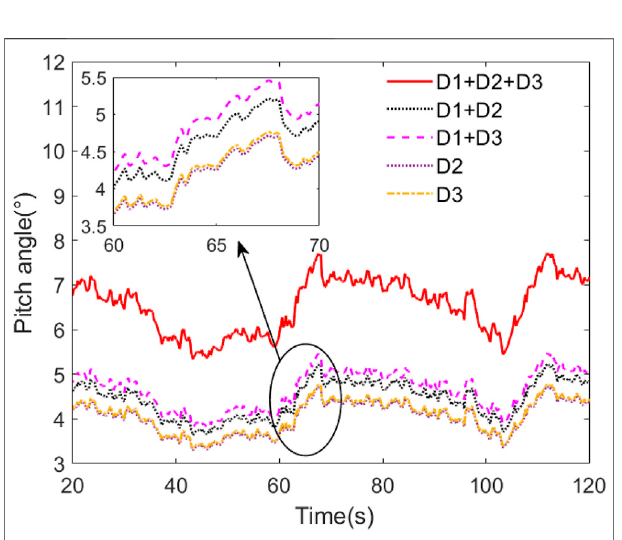
FIGURE 17 | Comparison curves of pitch angle under different disturbances.